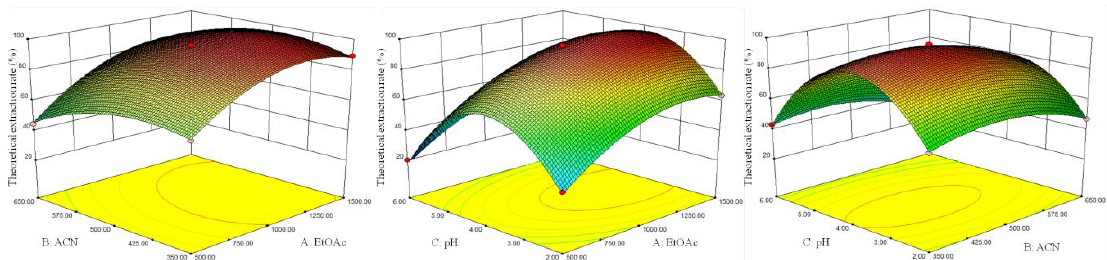
Figure 2. Response surface plots of syringic acid by response (%) versus significant variables (A, the amount of EtOAc; B, the amount of ACN and C, the pH of the